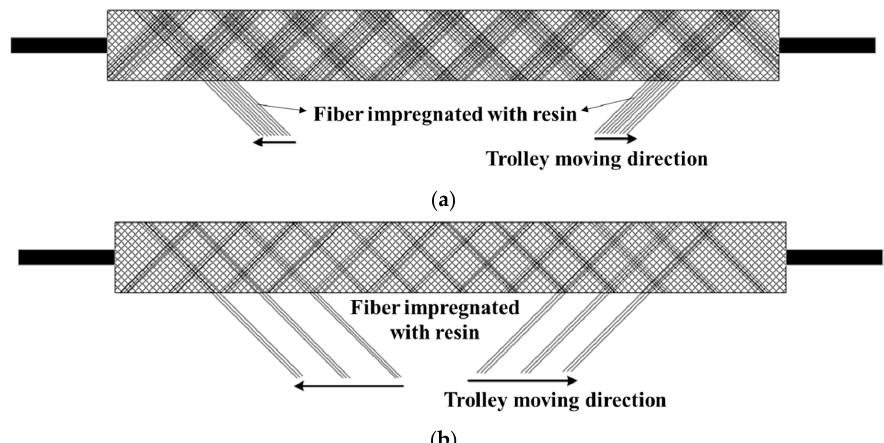
Figure 3. The schematic of moving direction for impregnated fiber: ( a ) Continuous arrangement; ( b ) spacing arrangement.